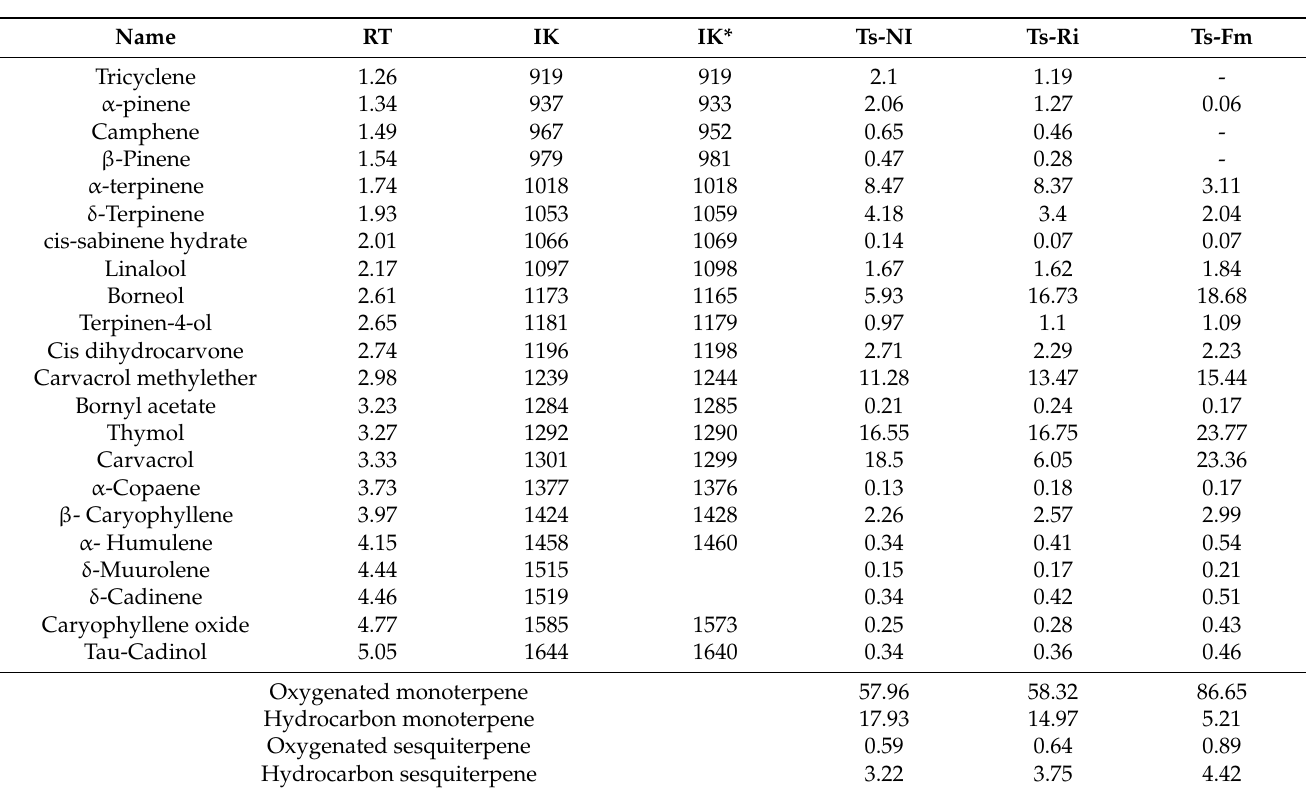
Table 1. Chemical composition of essential oil (in %) in inoculated and non-inoculated T. satureioides after 4 months of culture under greenhouse conditions. RT—retention time; IK—Retention indices calculated relative to n-alkanes (C-8 to C-40) using capillary column ZB-5MS; IK*—Retention indices found in the literature and The Pherobase [47]: Database of Pheromones and Semiochemicals;